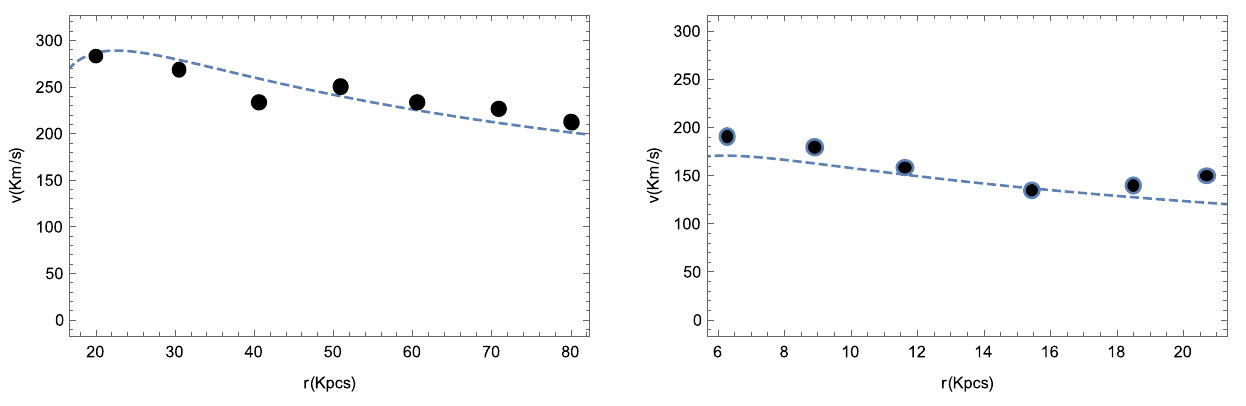
Fig. 2 Galacticrotationcurveobtainedfor δ ≈ O ( 10 − 6 ) withthe r 0 = 10 2 . 250 ≈ 177 . 828 kpc external to the visible end of galaxy NGC 4138. The black dots represent the observed data points due to HI